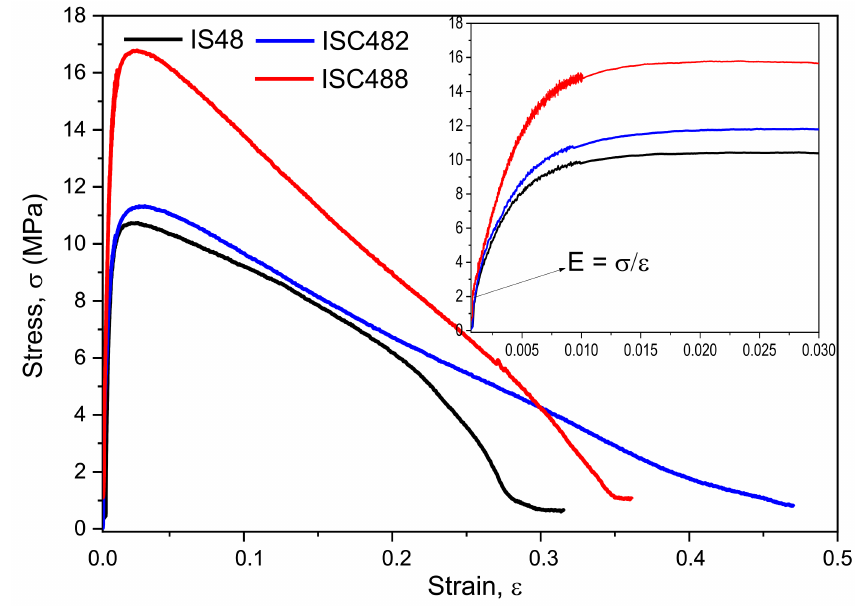
Figure 6. Typical stress–strain curves of IS48, ISC482 and ISC488